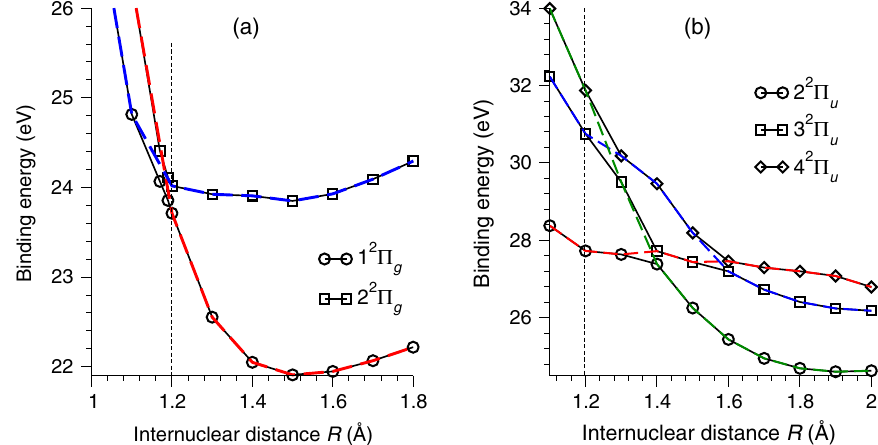
FIG. 8. The PECs of the (a) 2 (cid:2) and (b) 2 (cid:2) states around the avoided crossing points. The marked points (see the legends) show the g u ab initio adiabatic energies, and dashed lines propose the R dependence of the diabatic states. The equilibrium position of the core- excited state (FC region) is shown with the vertical dashed